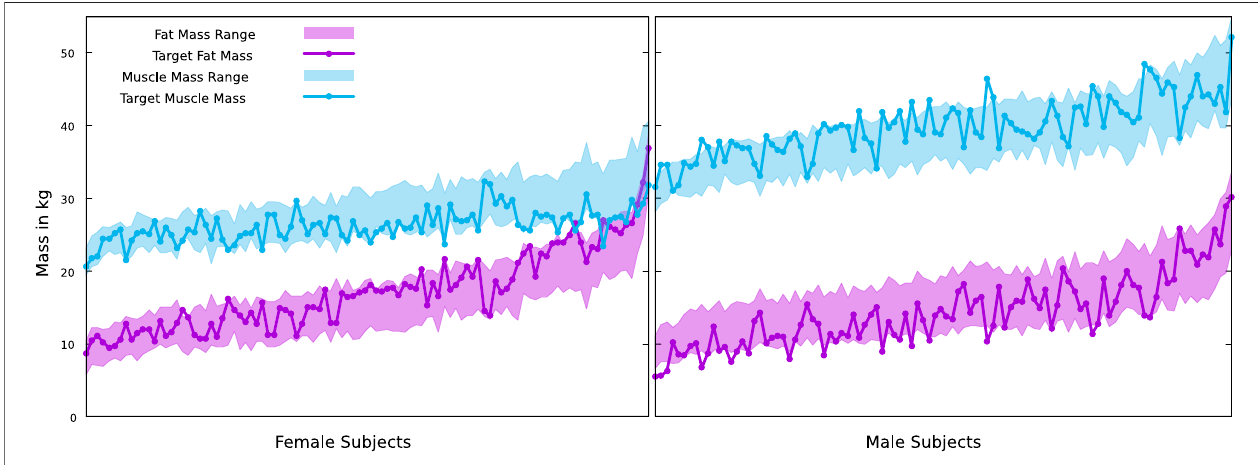
FIGURE8| TruemuscleandfatmassesforthefemaleandmalesubjectsoftheBeyondBMIdataset,plottedontopofthepossiblerangesde fi nedbyourminimum and maximum muscle surfaces. Note that our minimal fat mass is coupled to the maximal muscle mass and vice versa.